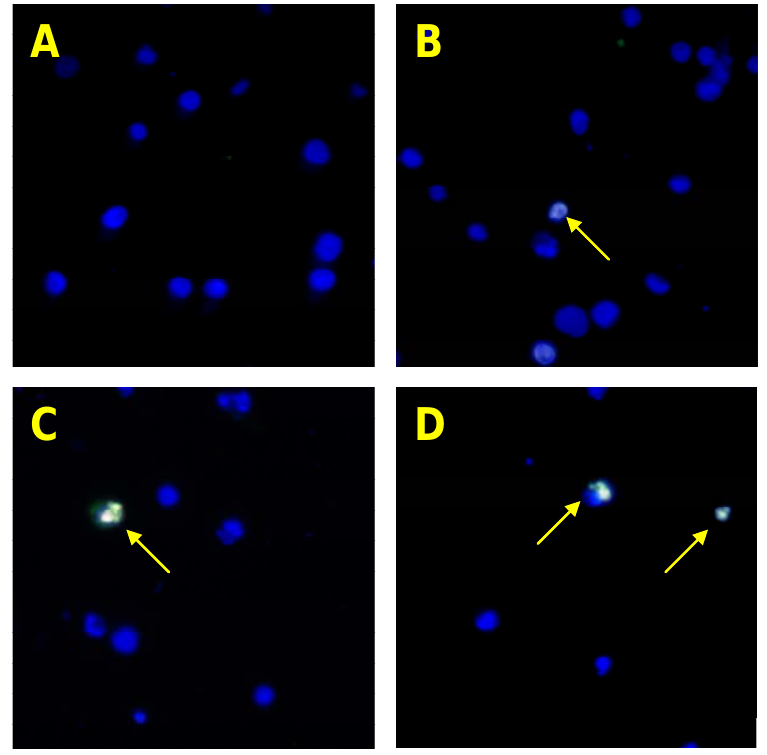
Figure 6. Detection of apoptotic cell deaths by fluorescence microscopic using annexin V- FITC, Ethidium Homodimer III and Hoechst 33342 staining. The healthy cells (stained with Hoechst 33342) emitted blue fluorescence and apoptotic cells (stained with Annexin V-FITC and Hoechst 33342) emitted green and blue fluorescence. ( A ) Control cells, ( B ) cells incubated with TRAIL (100 ng/mL), ( C ) cells incubated with neobavaisoflavone (50 μ M), ( D ) cells incubated with neobavaisoflavone (50 μ M) and TRAIL (100 ng/mL). Cells undergone apoptosis showing nuclei shrinkage, chromatin condensation and nuclei fragmentation, indicated by